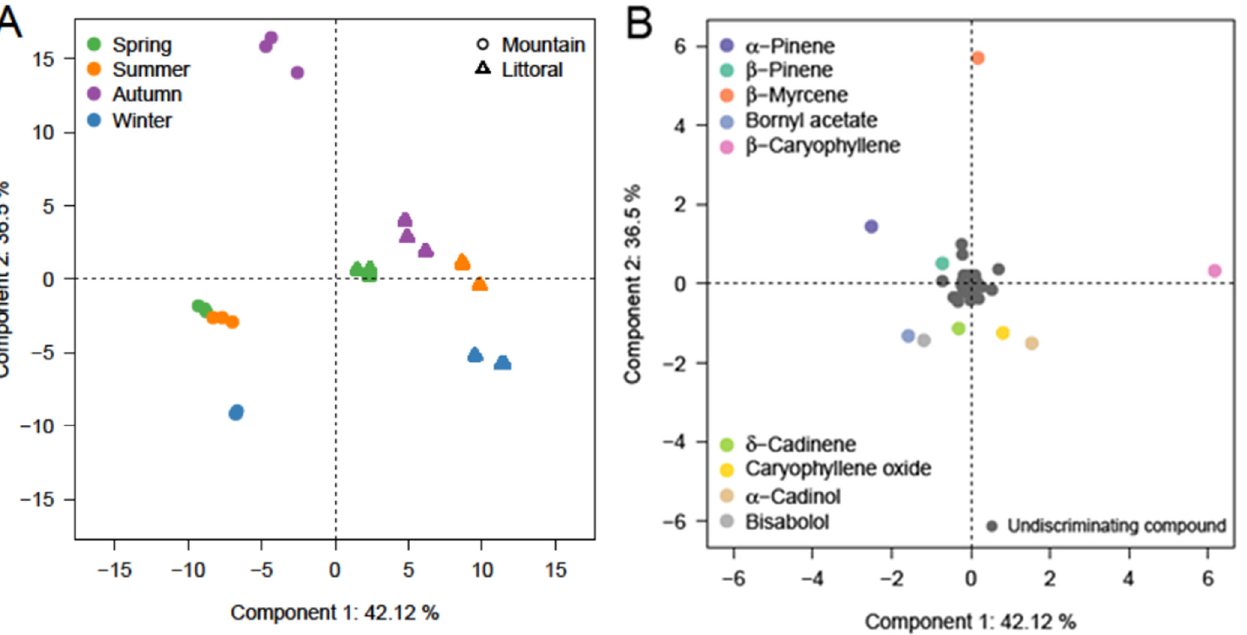
Figure 1. PCA analysis performed on all the compounds from the essential oils of Pistacia lentiscus leaf samples collected at the two altitude sites ( △ for littoral versus ◯ for mountain) and in 4 consecutive seasons: ( A ) score plot of PC1 versus PC2 scores; ( B ) loading plot of PC1- and PC2-contributing EO compounds (the most discriminating compounds are represented in color).